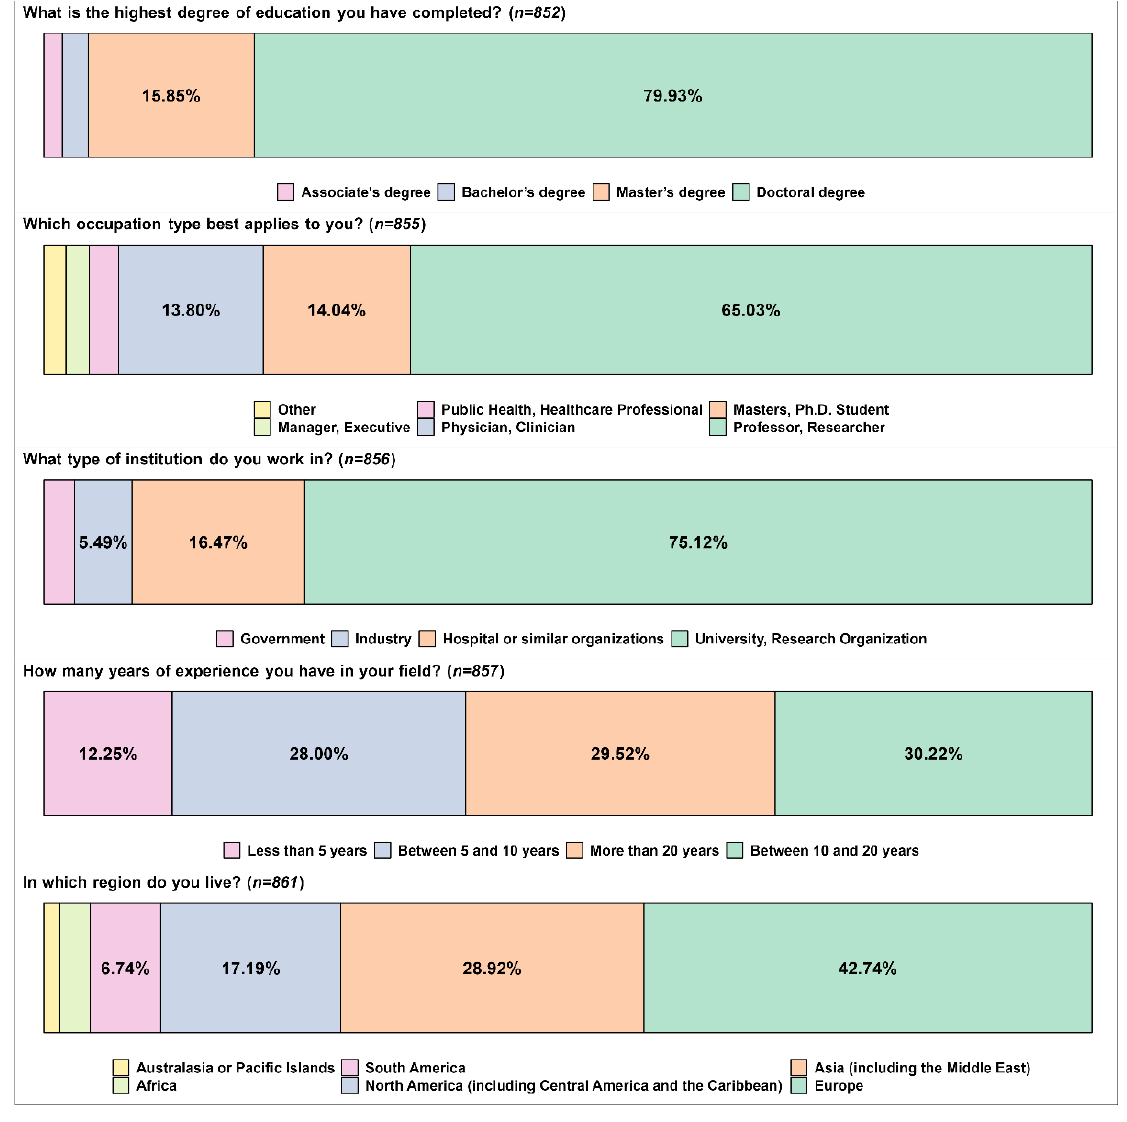
Figure 1. Demographic profile of the